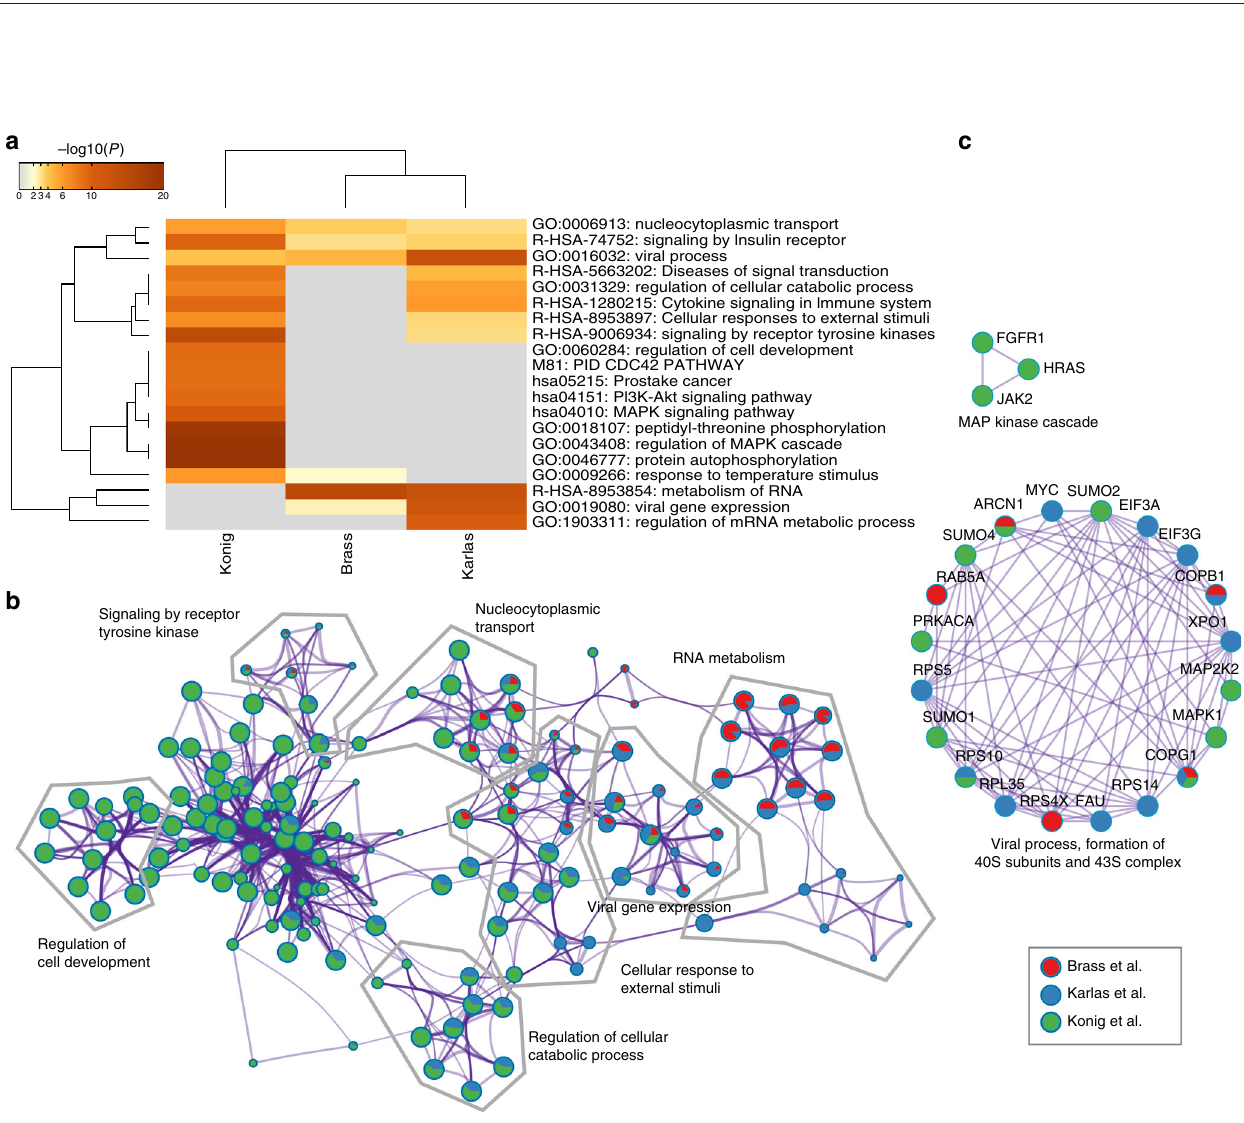
Fig. 3 Visualizations of meta-analysis results based on multiple gene lists. a Heatmap showing the top enrichment clusters, one row per cluster, using a discrete color scale to represent statistical signi fi cance. Gray color indicates a lack of signi fi cance. The category GO:0016032 (viral process) is common to all studies, while GO:0046777 (protein autophosphorylation) is enriched exclusively in a single study, and is therefore likely a process associated with one particular experimental system. b Enrichment network visualization for results from the three gene lists, where nodes are represented by pie charts indicating their associations with each input study. Cluster labels were added manually. Color code represents the identities of gene lists. The network shows that processes such as viral gene expression, nucleocytoplasmic transport, and cellular response to external stimuli are generally shared among all three lists. RNA metabolism is shared between the Brass and Karlas lists; cellular development processes are mostly shared between the Karlas and Konig lists. c Selected MCODE components identi fi ed from the combined list of 541 genes, where each node represents a protein with a pie chart encoding its origin. The complex related to viral process is shared among all three lists, while the complex related to the MAP kinase cascade is speci fi c to the Konig list. Supplementary Figure 12 presents all MCODE components identi fi ed